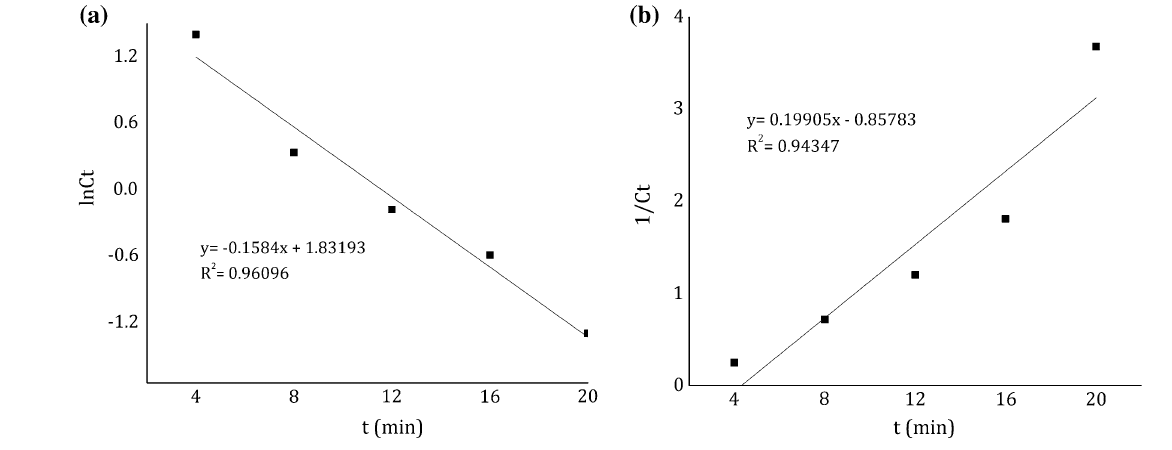
Fig. 6 Kinetic model plots of a pseudo-first order and b pseudo-second order Table 9 Kinetic model constants and correlation coefficients First